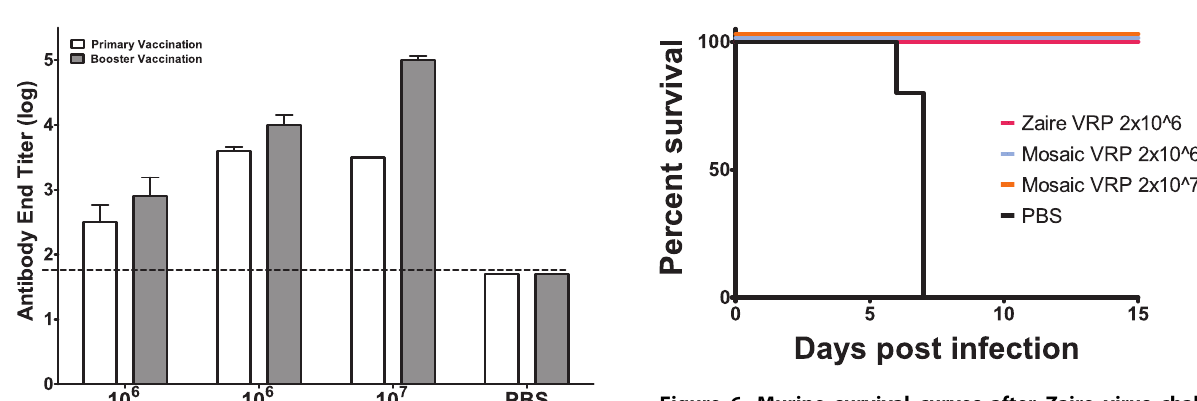
Figure 6. Murine survival curves after Zaire virus challenge. Survival curves for 4 cohorts of 10 female C57BL/6 mice are shown versus time after challenge with 950 plaque-forming units (pfu) of mouse-adapted Zaire virus. One cohort (red line) was vaccinated with 2 ? 10 6 pfu of a virus-like replicon particle (VRP) expressing GP from Mayinga Zaire virus, the second cohort (blue line) was vaccinated with 2 ? 10 6 pfu of a VRP expressing a GP mosaic protein, the third cohort (orange) was vaccinated with 2 ? 10 7 pfu of the same VRP expressing a GP mosaic protein, the fourth cohort served as controls and were sham vaccinated with phosphate buffered saline (PBS). The mosaic protein expressed by the VRP is the most Zaire-like protein from the 4-protein mosaic cocktail optimized against the original set of filovirus sequences. A single mosaic protein from the cocktail was used because experimental resources were